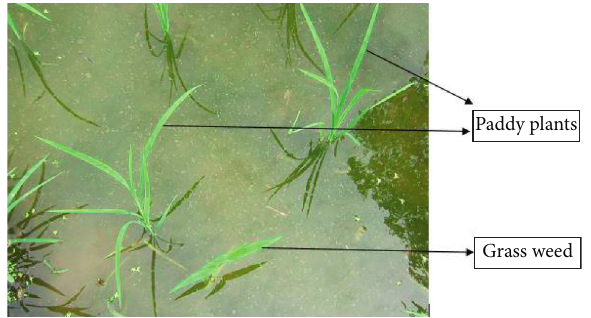
Algorithm 1. For the final class selection, the probability of